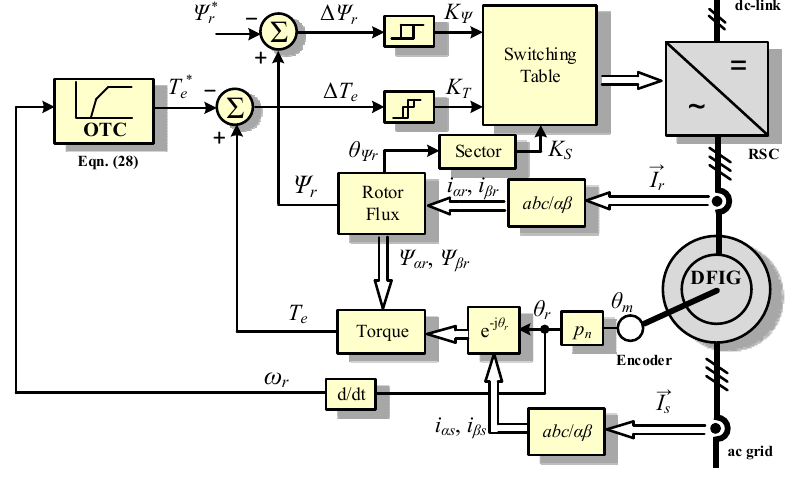
Figure 4. Schematic of the DFIG control.